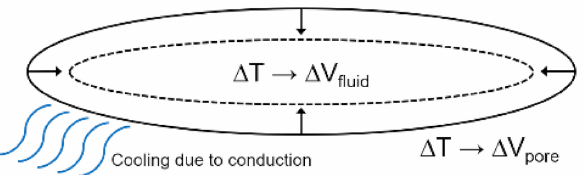
Figure 2. Contraction of fluid ( ∆ V fluid ) and pores ( ∆ V pore = ∆ V bulk − ∆ V grain ) due to cooling. When the pores contract more than the fluid the fluid is compressed, fluid pressure increases, and vice versa, when the contraction of the fluid is bigger than the contraction of the pores the fluid pressure